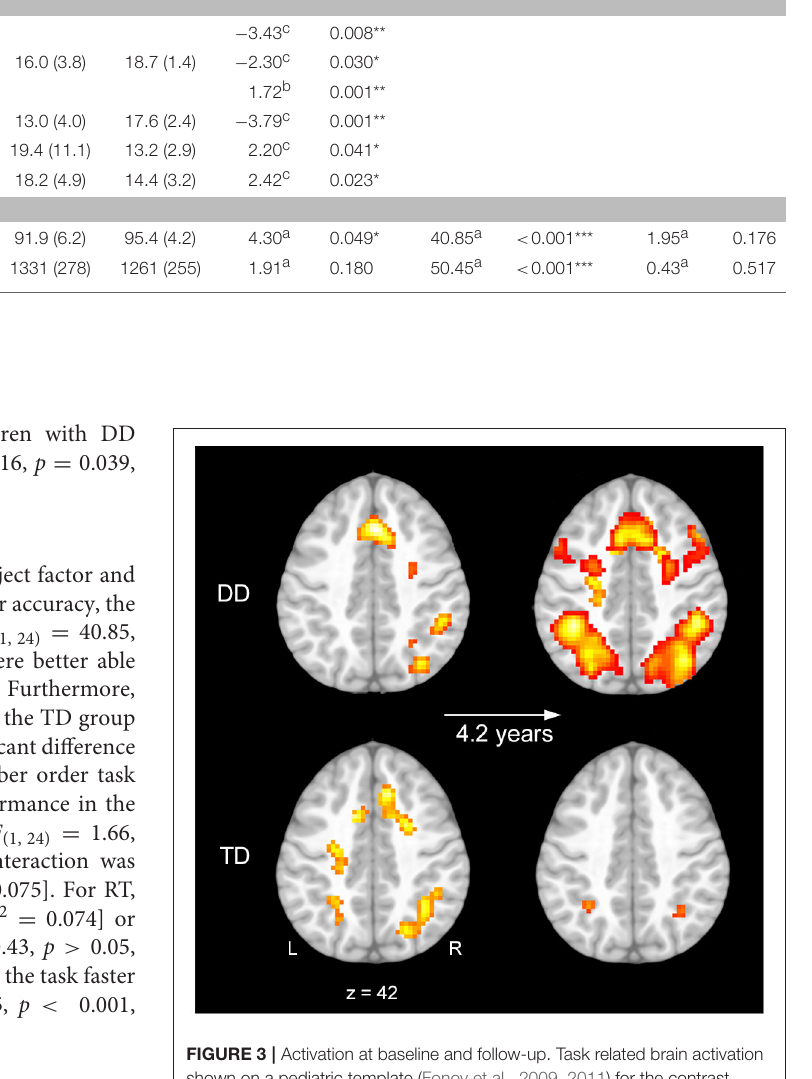
At follow-up, two-sample t -tests revealed significant differences between children with DD and controls ( Figure 4A , Table 5 ). Children with DD showed increased activation in frontal areas including bilateral middle frontal gyri (MFG)